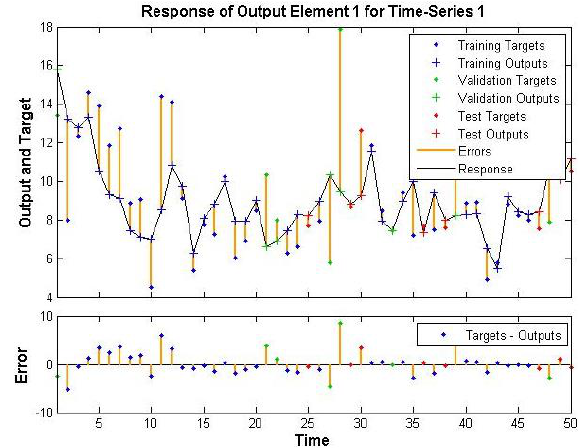
Figure 3. Time series of neural network training M c 2 run 1 PM 2.5 .